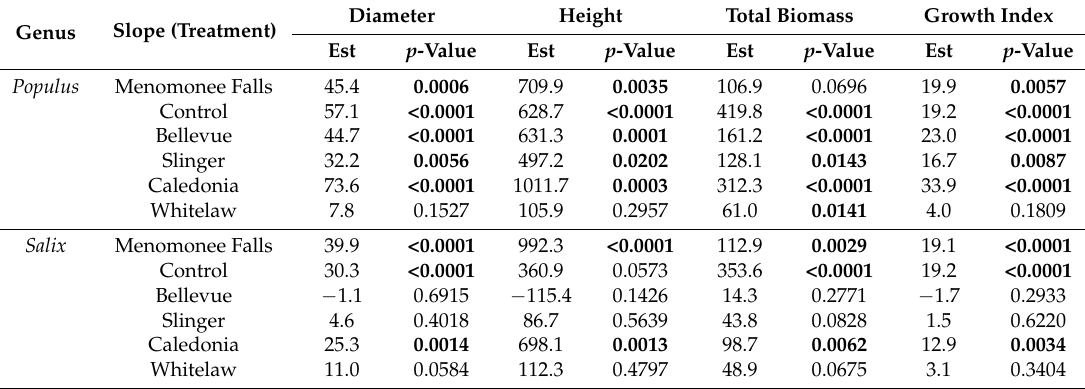
Table 7. Slope parameter estimates and associated p -values for the relationship between root–shoot ratio (RSR) and diameter, height, total dry biomass, and growth index in a study assessing the relationships among root–shoot allocations, early growth, and health of hybrid poplar and willow clones when grown for 65 days in soils from five landfills in eastern Wisconsin,